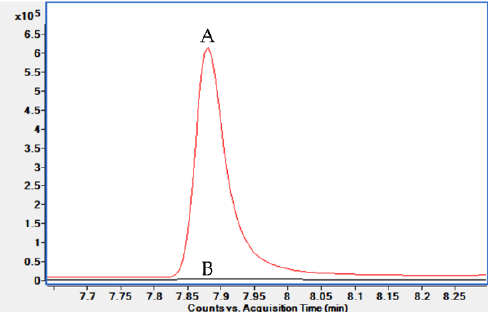
Figure A1. SIM chromatograms of SCFA standard mixture dissolved in water.